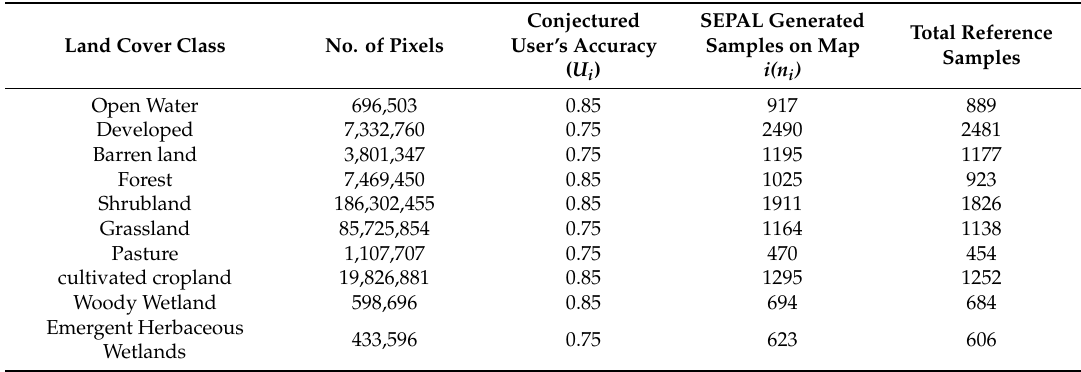
Table 3. A summary of the reference samples collected over each NLCD class over all six counties during the study period